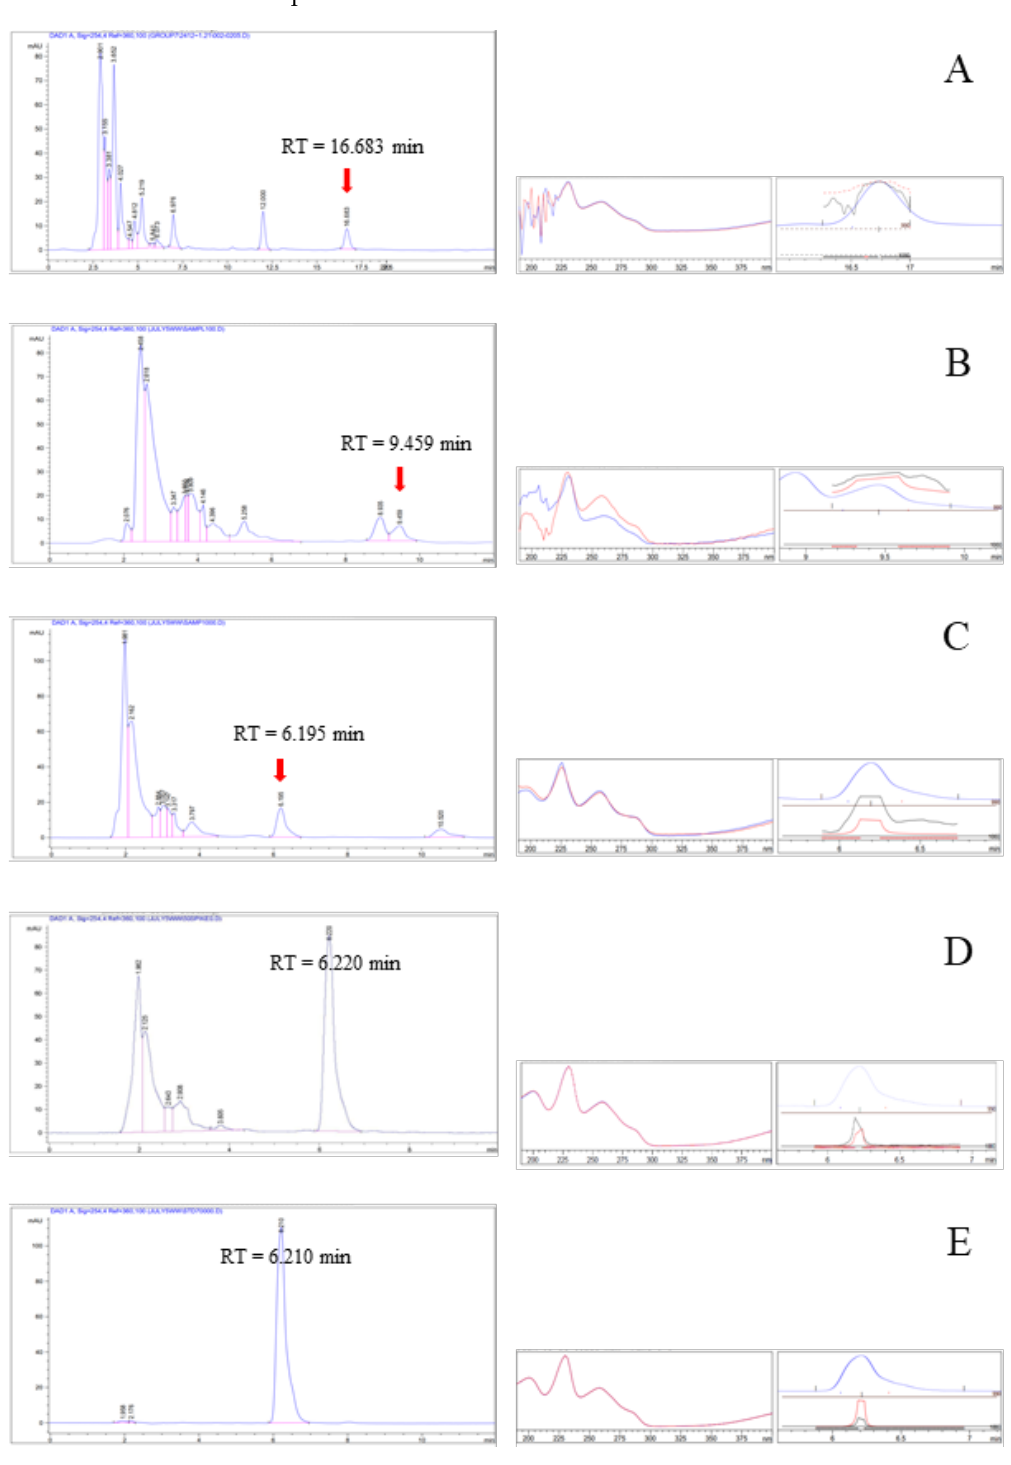
Figure 2. HPLC chromatograms of S. alata leaf extract analyzed under condition A ( A ), condition B ( B ) and condition C ( C ) and with extract spiked with rhein analyzed under condition C ( D ) and standard rhein analyzed under condition C ( E ) with a 254 nm detection wavelength.